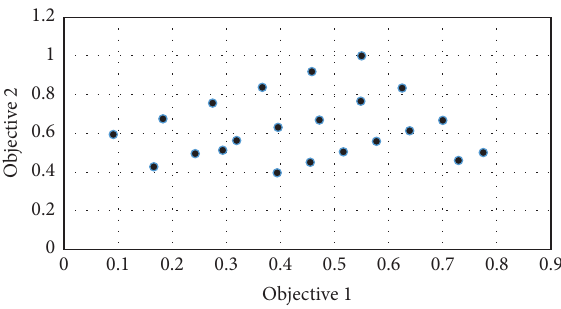
Figure 3: 2D diagram of normalized value.